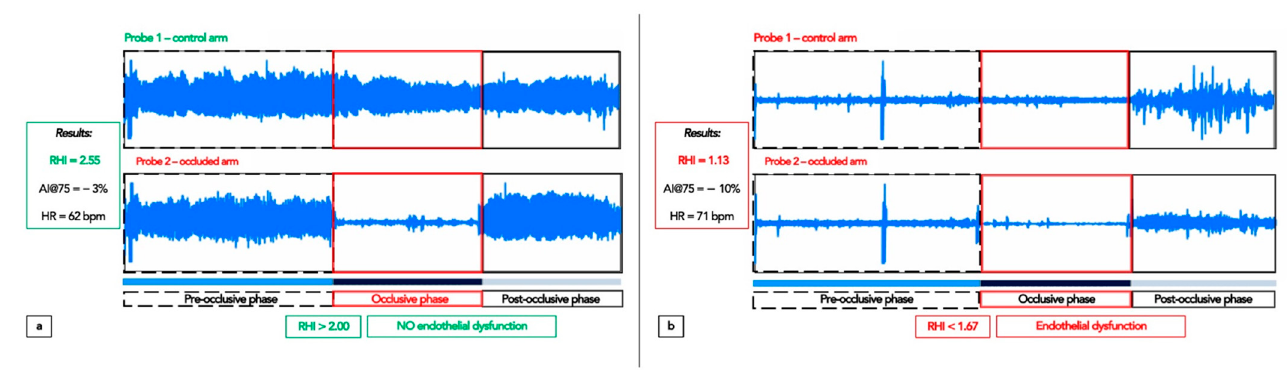
Figure 4. Peripheral arterial tonometry (PAT) signals obtained using the EndoPAT-2000 device, showing traces typical of good endothelial function ( a ) and of endothelial dysfunction ( b ). Note the difference in the post-occlusive phase, with lower amplitude, similar to baseline trace, in the